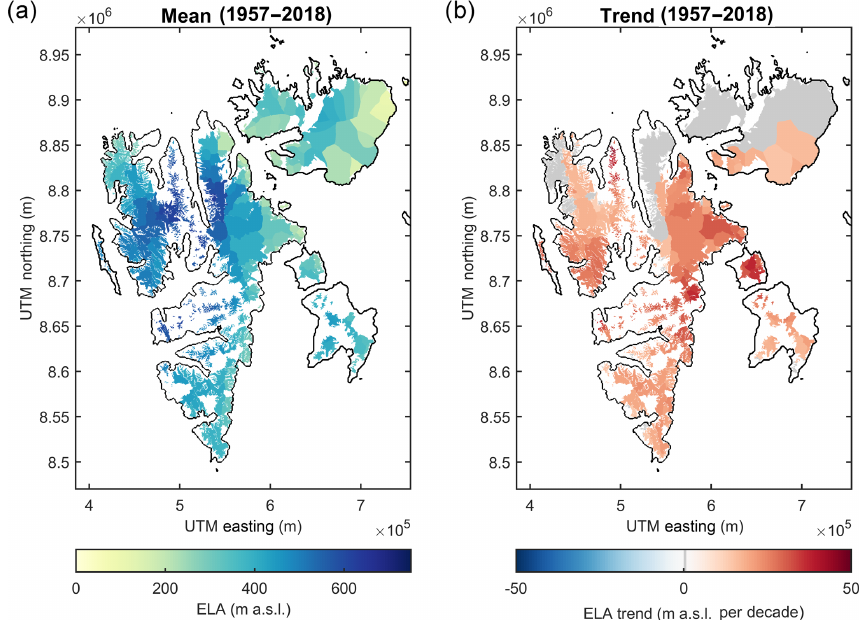
Figure 6. Long-term mean spatial ELA distribution (a) and trends (b) . Data are averaged per glacier basin, based on the glacier outline database in König et al.